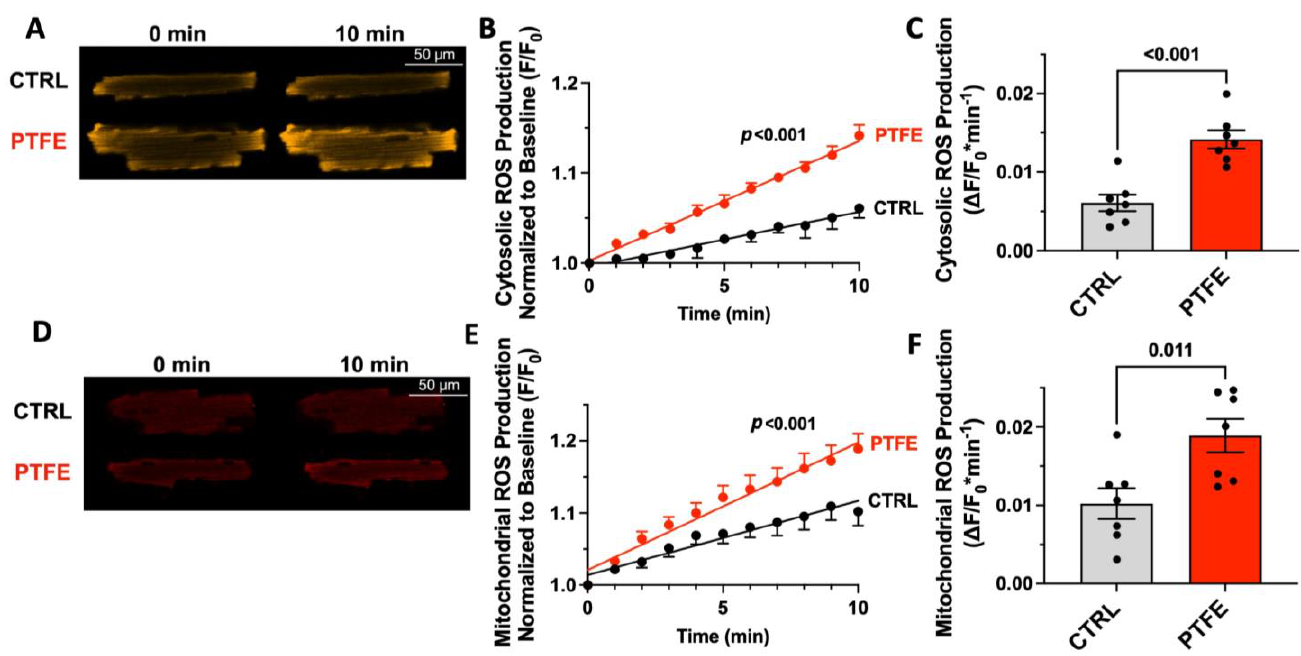
Figure 3. ( A ) Original confocal frame scans of isolated ventricular cardiomyocytes loaded with the cytosolic ROS fluorescence dye CellRox TM Orange. ( B ) Fluorescence intensity over time, normalized to baseline ( p < 0.001 for difference in linear regression slopes). ( C ) Mean data per animal for the increase in CellRox TM Orange fluorescence intensity normalized to baseline fluorescence (ΔF/F 0 ) at 10 min after start of recording ( n = 7 vs. 7). ( D ) Original confocal frame scans of isolated ventricular cardiomyocytes loaded with the mitochondrial ROS fluorescence dye MitoSox TM Red. ( E ) Fluorescence intensity over time, normalized to baseline ( p < 0.001 for difference in linear regression slopes). ( F ) Mean data per animal for the increase in MitoSox TM Red fluorescence intensity normalized to baseline fluorescence (ΔF/F 0 ) at 10 min after start of recording ( n = 7 vs. 7). Statistical comparisons are based on Student’s t -test.